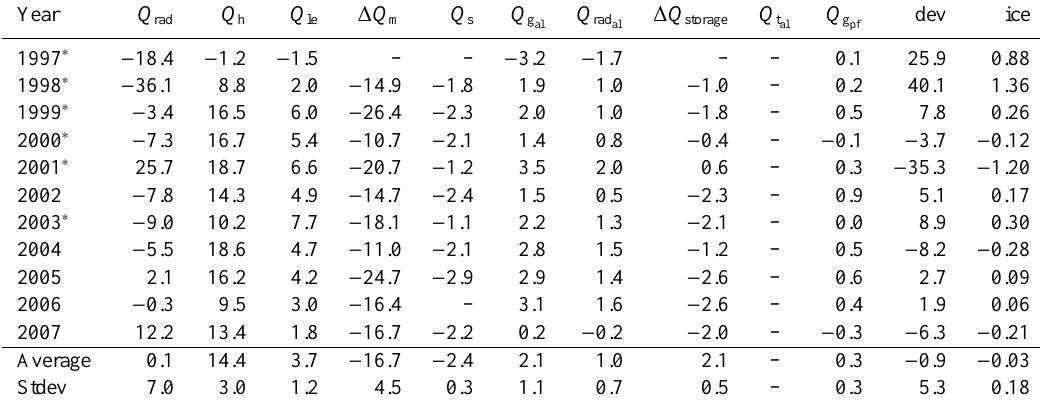
Table 4. Seasonal (February–May) averages of the energy balance components with deviations (in Wm − 2 ) and corresponding ice thickness equivalents (in m). Years marked with an asterik were not considered for the calculation of the average and the standard deviation. Q rad : Net radiation; Q h : Sensible heat flux at the surface; Q le : Latent heat flux at the surface; ∆ Q m : Melt energy in the snow cover; Q s : Conductive heat flux through the snow; Q g : Conductive heat flux within the active layer; Q rad : Net radiation in the active layer; ∆ Q storage : Change in heat al al content in the active layer; Q t : Turbulent heat flux in the active layer; Q g : Conductive heat flux through the permafrost table; dev: Energy al pf balance closure; ice: Ice melt equivalent of the energy balance